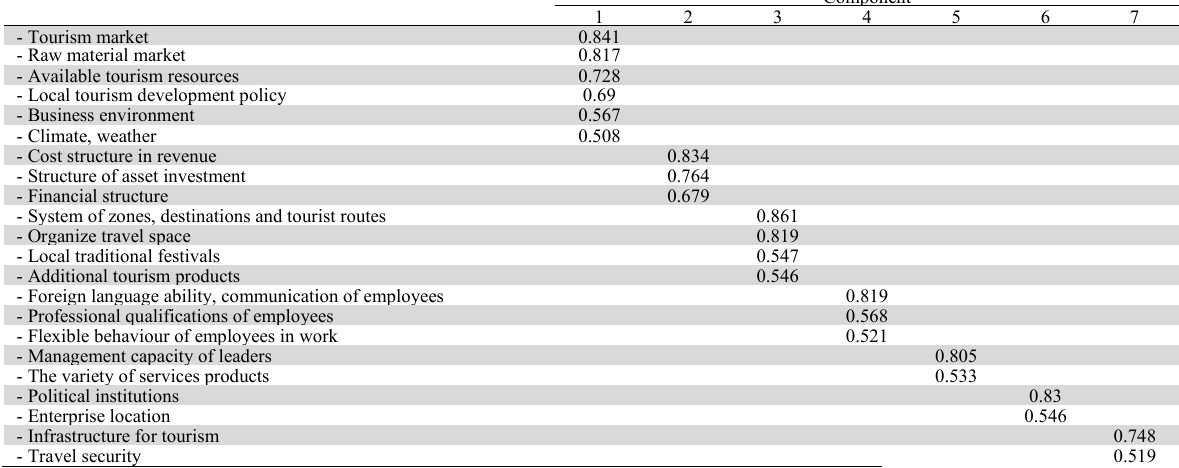
Impact of the exploratory factor group on the profitability of the tourist enterprise in BinhDinh